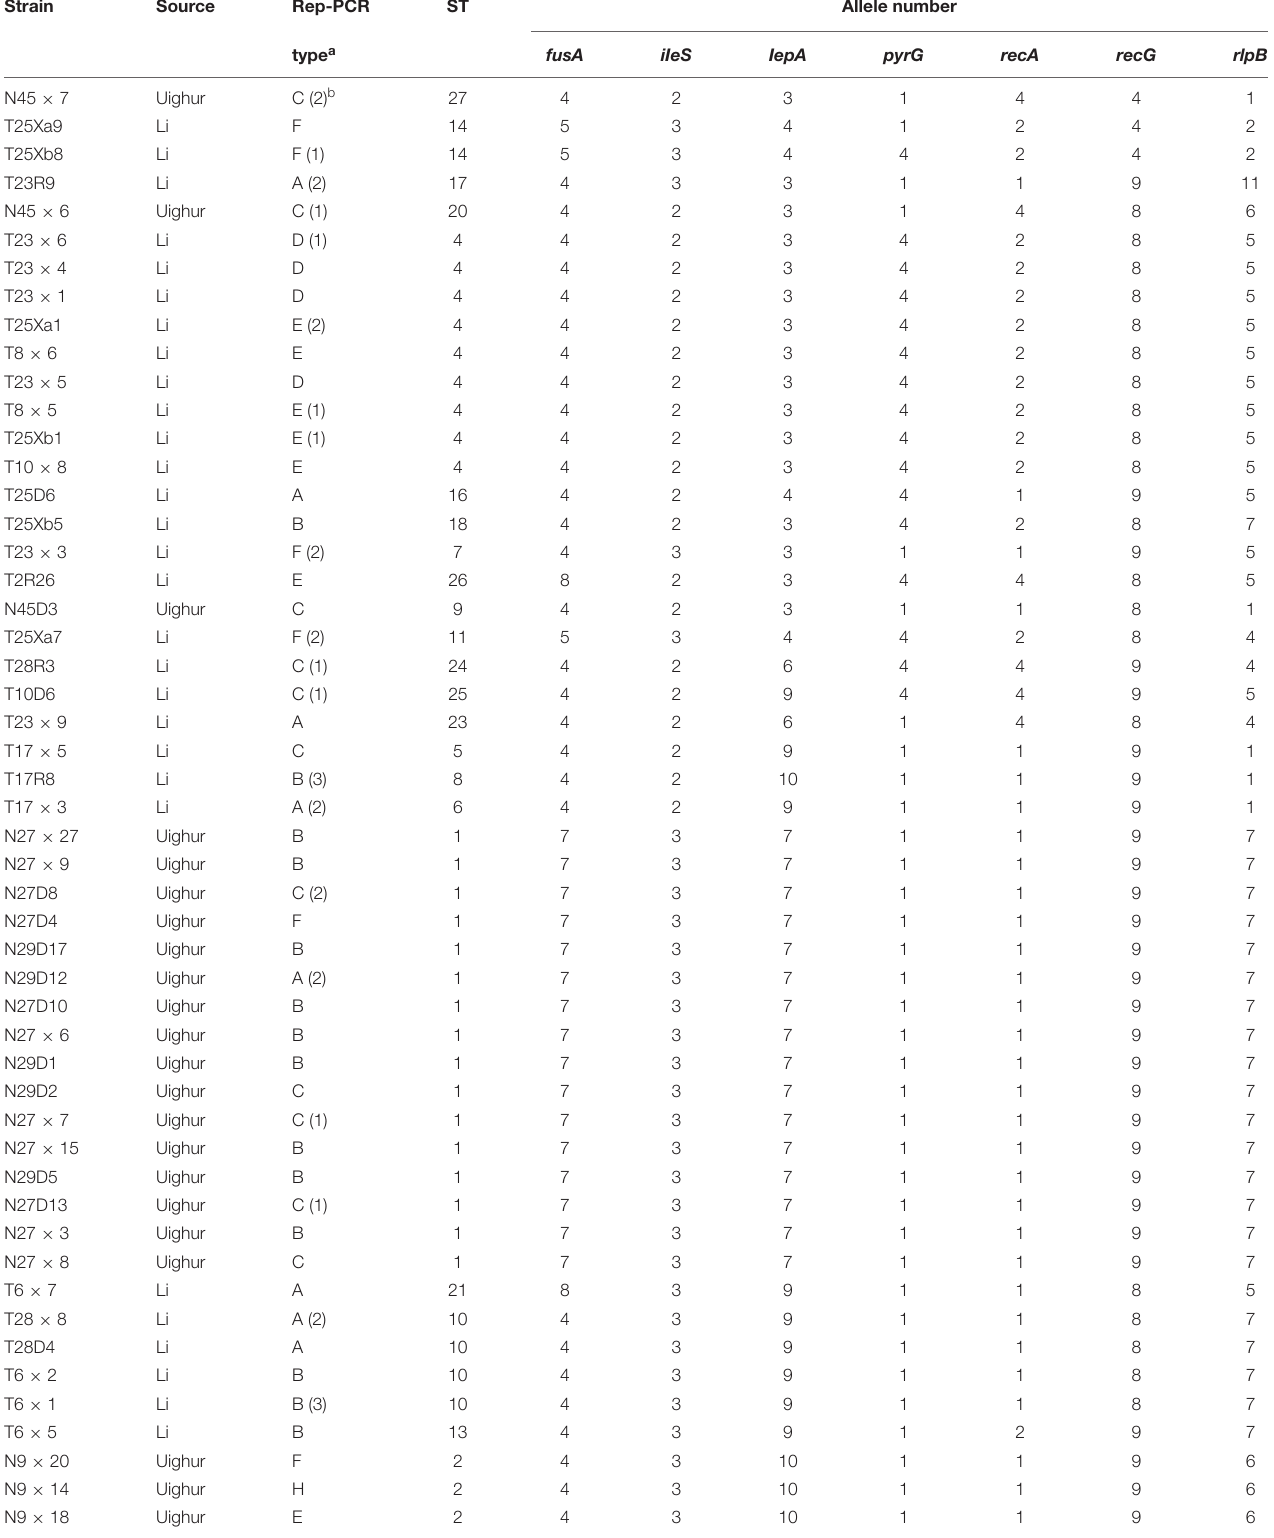
TABLE 4 | STs and Allelic profiles of 106 L . paracasei